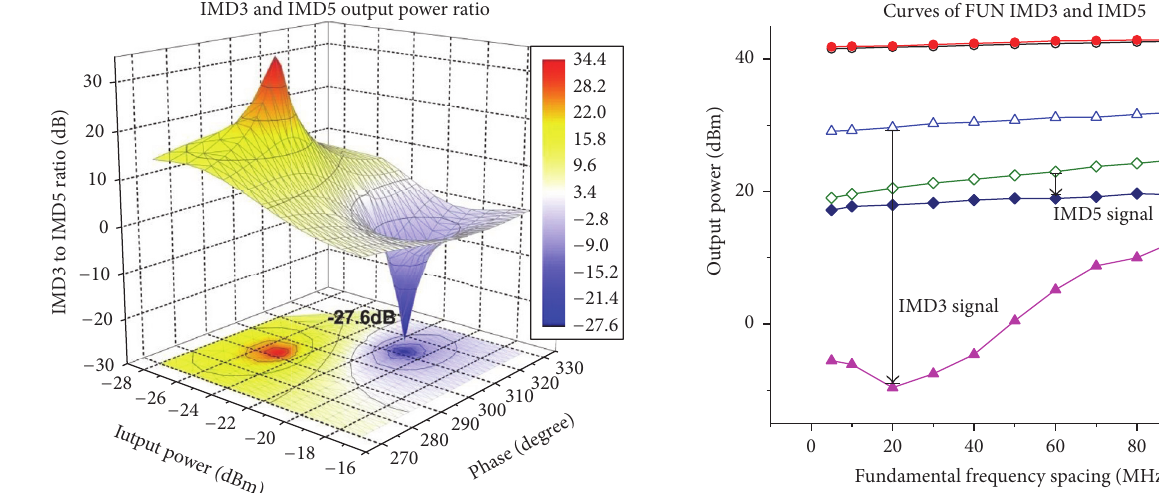
Figure 6: The 3D plot of TFR IM 3 according to the phase and to IM 5 amplitude of injected IM3+ signal. Figure 8: Suppression situation for IMD3+ and IMD5+ under opti- mal signal injection according to fundamental frequency spacing (1MHz ∼ 100